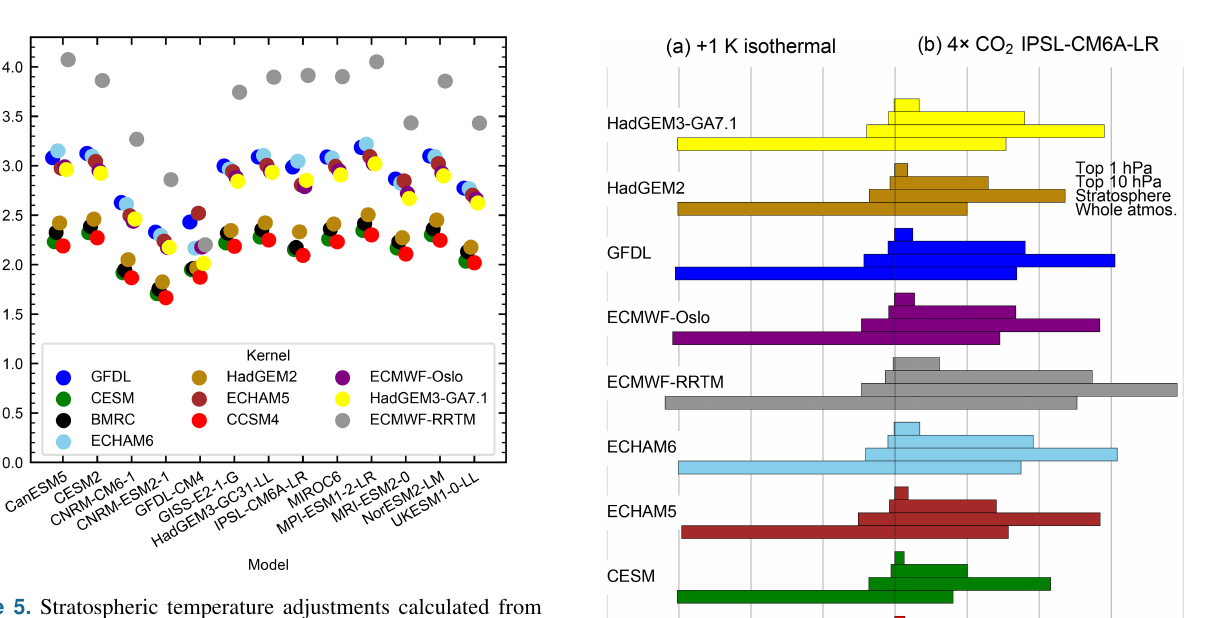
Figure 5. Stratospheric temperature adjustments calculated from RFMIP piClim-4 × CO 2 experiments using all kernels available in this study.